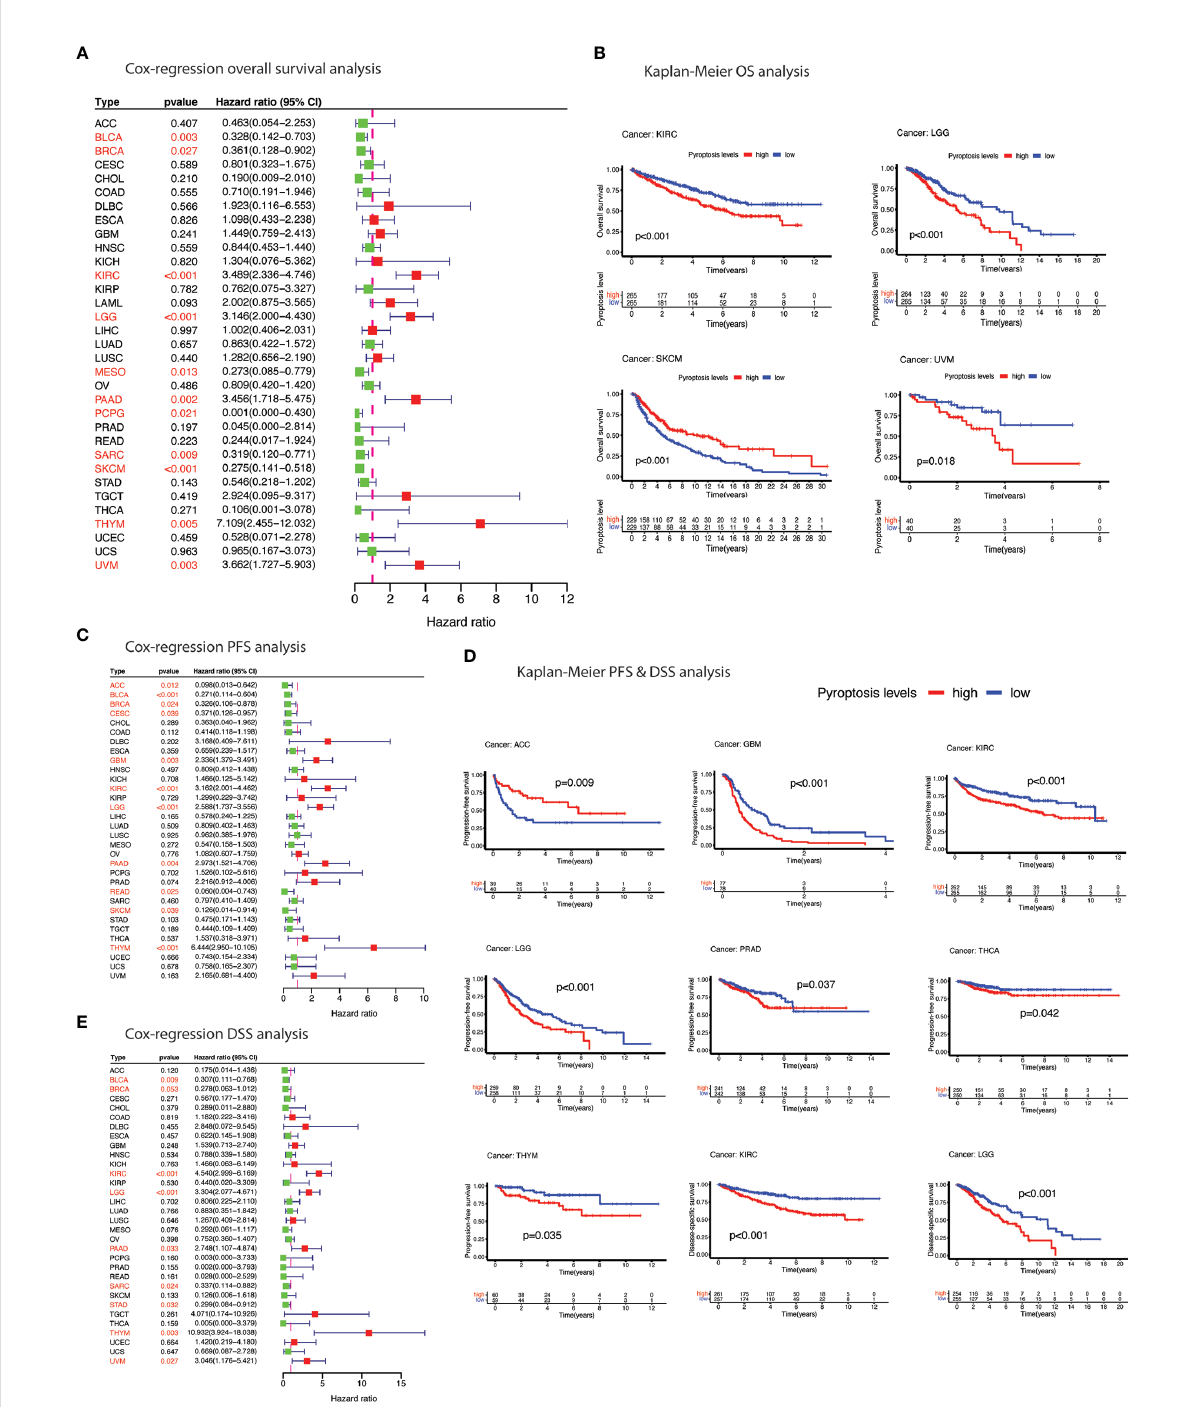
FIGURE 5 Prognostic signi fi cance of pyroptosis in cancer. (A) Forest plot of cox-regression overall survival (OS) difference between pyroptosis-low and pyroptosis-high groups. (B) Kaplan-Meier curves depicting overall survival (OS) difference between pyroptosis-low and pyroptosis-high groups. (C) Forest plot of cox-regression progression-free survival (PFS) difference between pyroptosis-low and pyroptosis-high groups. (D) Kaplan- Meier curves depicting progression-free survival (PFS) & disease-speci fi c survival (DSS) difference between pyroptosis-low and pyroptosis-high groups. (E) Forest plot of cox-regression disease-speci fi c survival (DSS) difference between pyroptosis-low and pyroptosis-high groups. Red color indicates signi fi cant survival difference